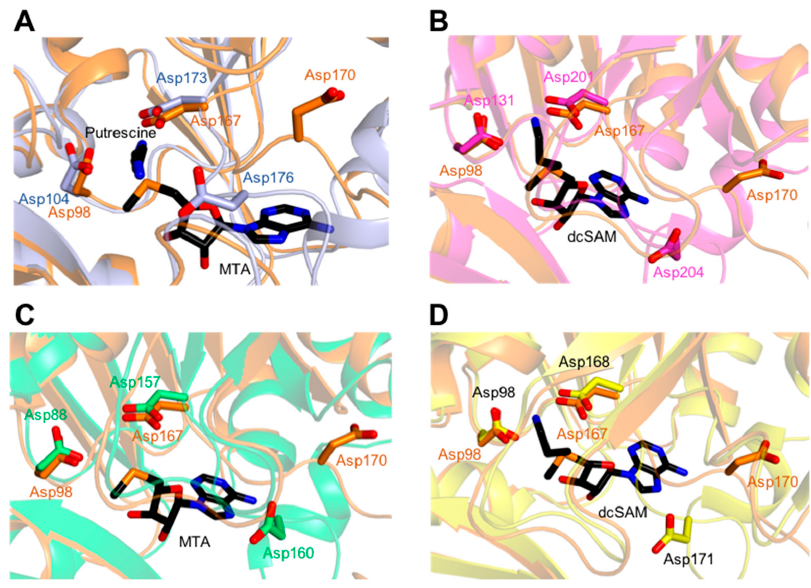
Figure 3. Structural comparisons of the three key aspartic residues in the active site of spermidine synthase (SpdS) from five different species. In ( A – D ), the Kluyveromyces lactis SpdS ( Kl SpdS) monomer is shown in orange. ( A ) The Homo sapiens SpdS ( Hs SpdS) monomer is shown in light blue. ( B ) The Arabidopsis thaliana SpdS ( At SpdS) monomer is shown in warm pink. ( C ) The Plasmodium falciparum SpdS ( Pf SpdS) monomer is shown in lime green. ( D ) The Trypanosoma cruzi SpdS ( Tc SpdS) monomer is shown in yellow. Overall, most ligand-interacting residues were similar in the structures of Hs SpdS and Kl SpdS complexed with putrescine substrate, with the Tyr73, Asp167, and Ile240 res- idues in Kl SpdS aligning especially well with the corresponding Tyr79, Asp173, and Ile246 residues in Hs SpdS (Figure 4A). Putrescine generated four hydrogen bonds with the amino acids present in the active site, including three residues in the gate-keeping loop. With spermidine, most residues were well matched except for Ser174, Ser175, Asp176, and Try241 (Figure 4B), and it was stabilized by six of the seven possible hydrogen bonds be- tween the gate-keeping loop and the active site. With the cofactor dcSAM, most residues aligned well except for Glu124, Pro180, and Leu184 (Figure 4C). Similarly, most residues were matched when bound to the MTA byproduct, except for Glu124, Pro180, and Leu184 (Figure 4D). In particular, Glu124 in Kl SpdS corresponded to Asp118 in Hs SpdS, both are negatively charged, suggesting that there would be no critical change in enzyme activity. Superpositions between the Pf SpdS enzyme–inhibitor complex and apo- Kl SpdS structures (Figure 4E,F) revealed that the residues of Pf SpdS did not align well with those of Kl SpdS in SpdS–adoDATO complexes compared to Hs SpdS. However, all residues in SpdS– 4MCHA complex corresponded for Hs SpdS as well as Pf SpdS. Taken together, these fi nd- ings suggest that SpdS exhibits di ff erent inhibitory e ff ects when complexed with ado- DATO and 4MCHA.